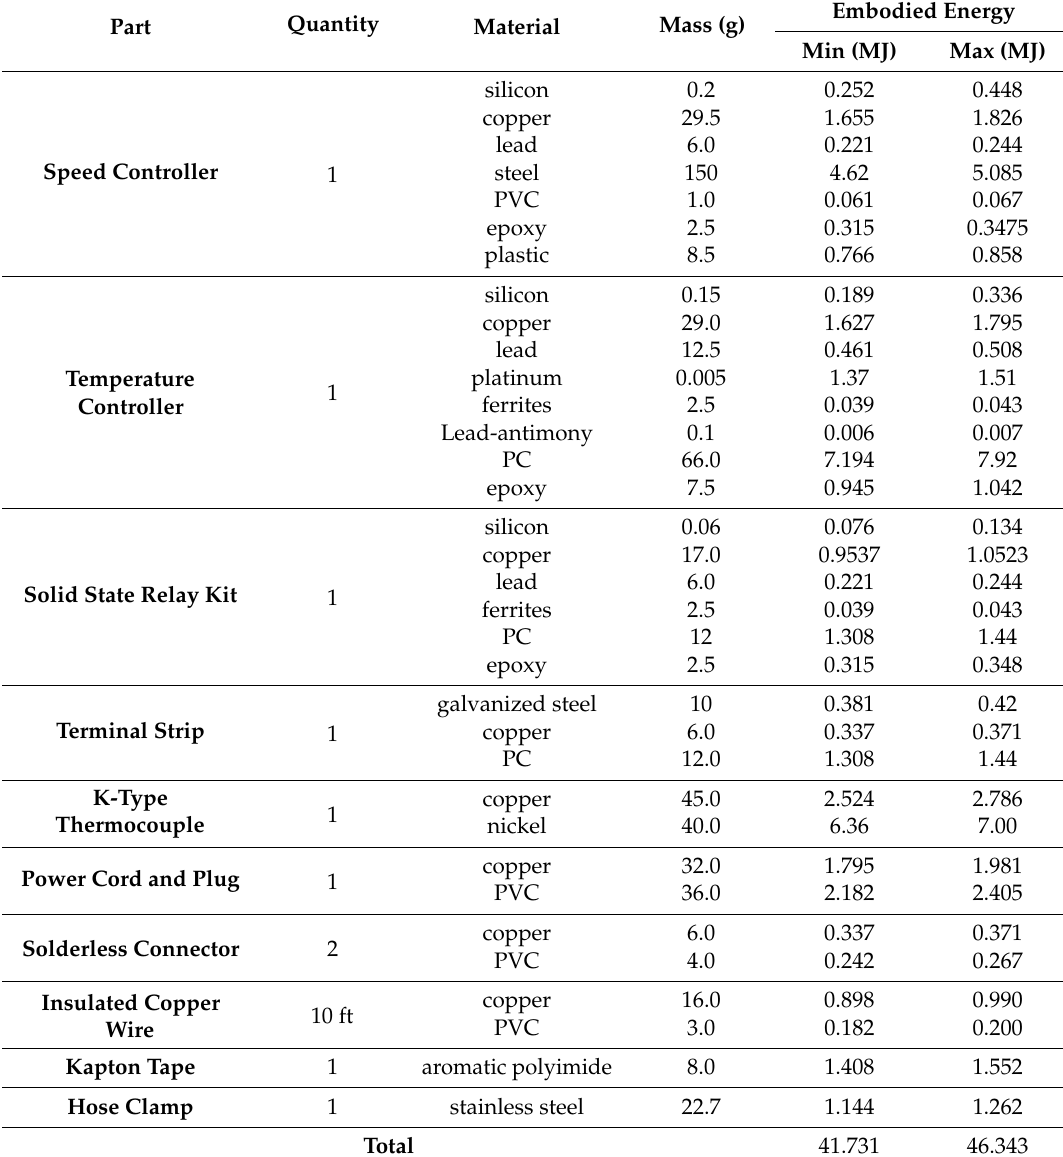
Table 4. Embodied energy for the electrical components and wiring part of the recyclebot.